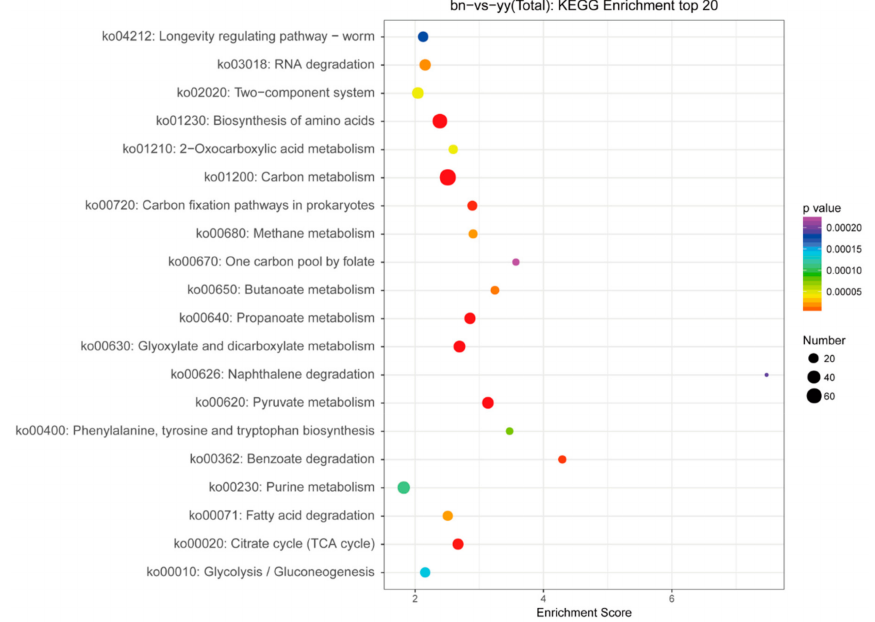
Figure 7. Top 20 bubble map of KEGG enrichment DEM target genes. The x -axis Enrichment Score is the enrichment score. The larger size bubble indicates a greater number of DEM target genes, and the smaller p -value means the greater